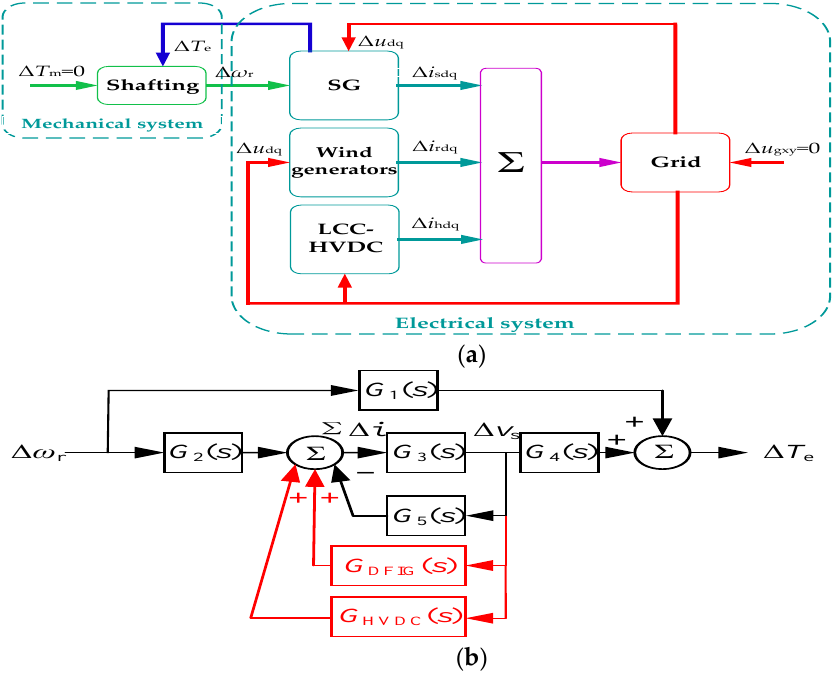
Figure 4. The dynamic interaction between various equipment and the SG: ( a ) SG electromechanical coupling mechanism; ( b ) speed disturbance transfer relationship.